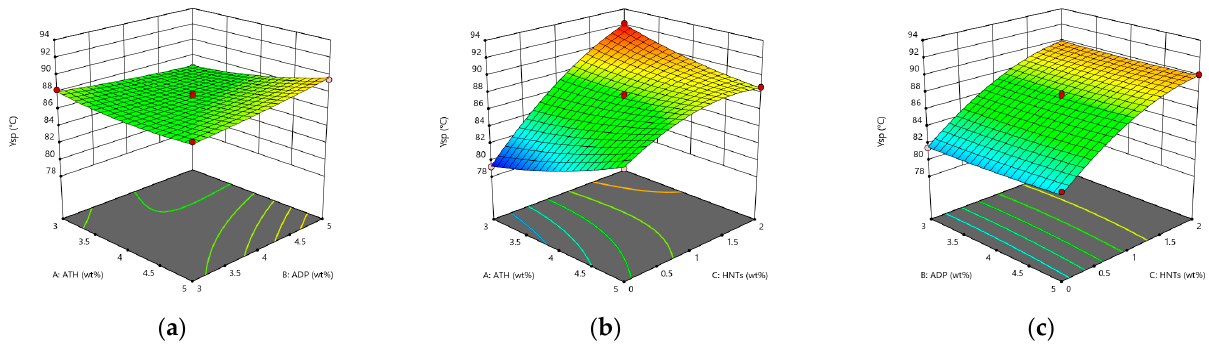
Figure 1. The response surface diagram of the flame retardant system to the change of penetration model: ( a ) Interactive effects of ATH and ADP; ( b ) Interactive effects of ATH and HNTs; and ( c ) Interactive effects of ADP and HNTs.